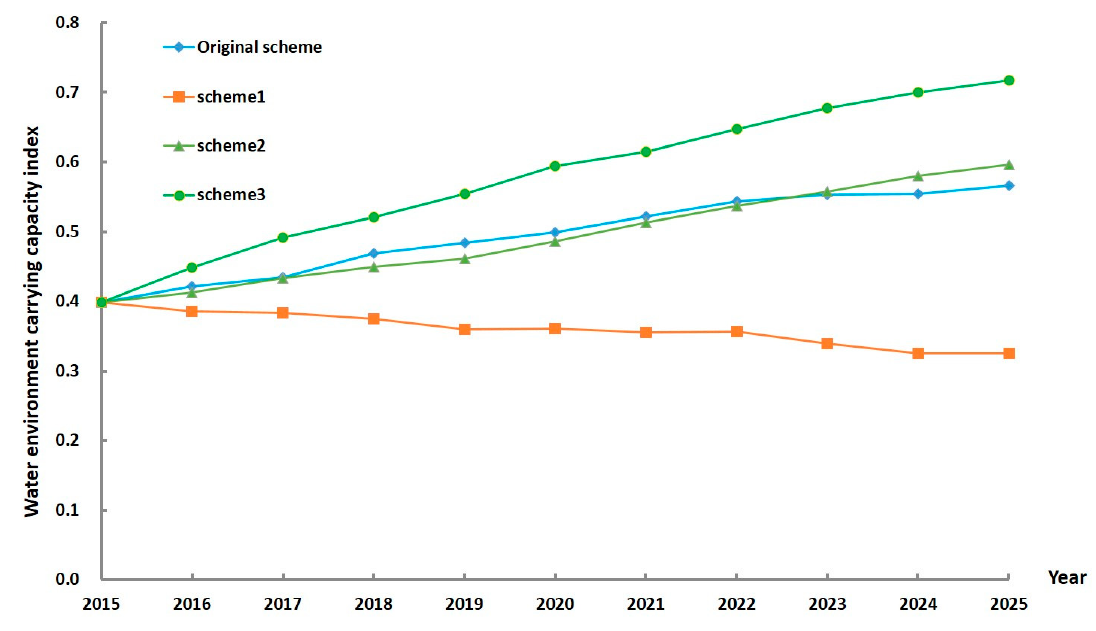
Figure 5. Results of WECC index in different schemes.